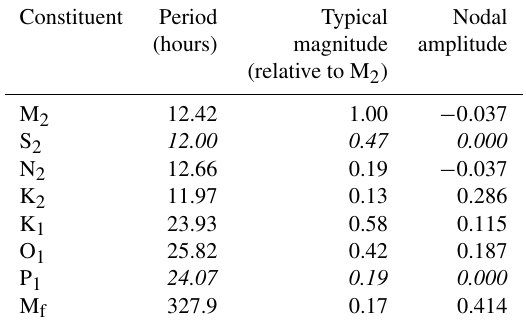
Table 1. Characteristics of the eight tidal constituents using in the parameterisation (Pond and Pickard, 1983; Pugh, 1987). Subscript 2 denotes semidiurnal tides, subscript 1 denotes diurnal tides, and subscript f denotes fortnightly tides. Negative nodal amplitude in- dicates that the modulation of the constituent is 180 ◦ out of phase. Italics indicate a pure solar tide that is not directly modulated by the lunar nodal cycle. Constituent Period Typical Nodal (hours)